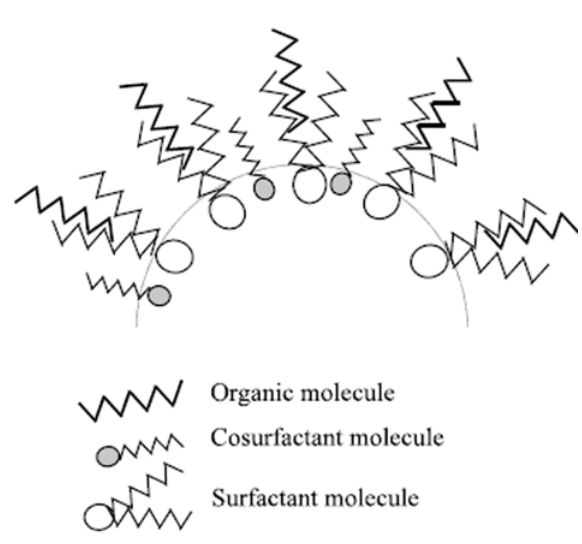
Figure 6. Schematic representation of an interface including surfactant and cosurfactant. Reproduced from reference [17] with permission from